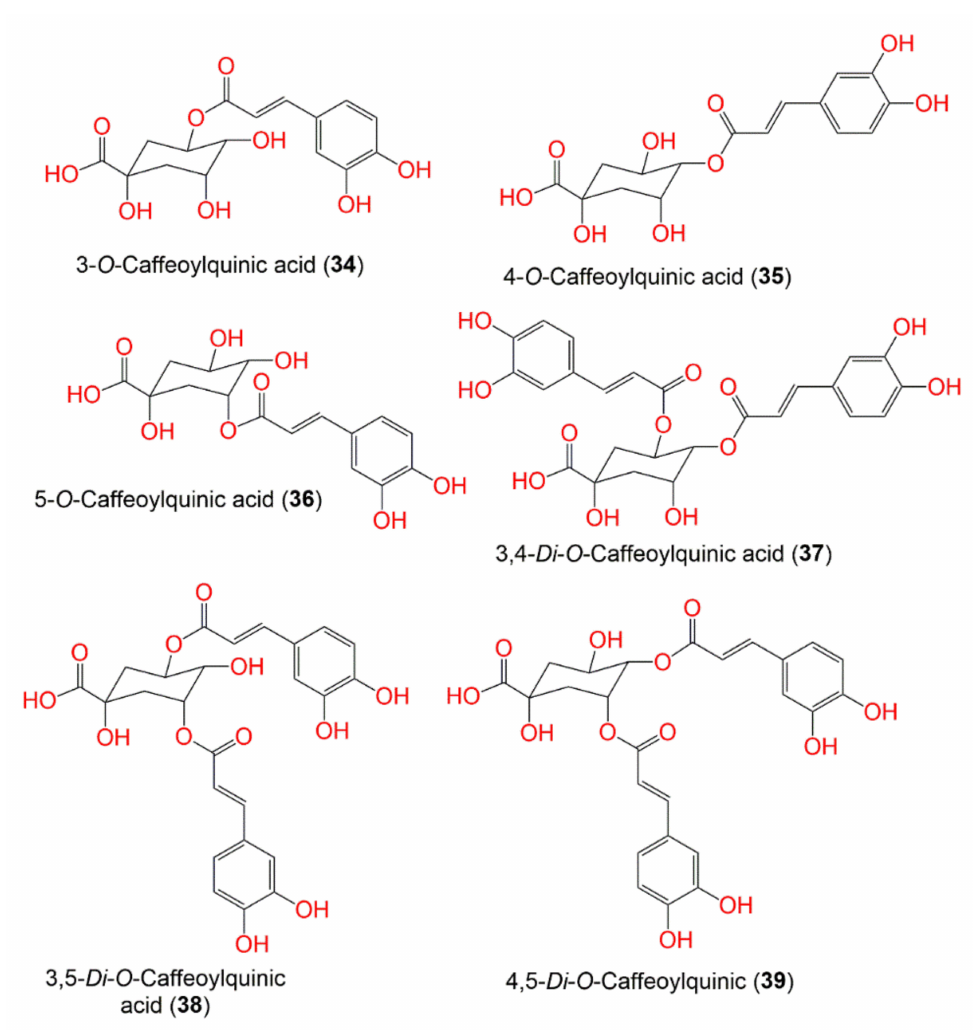
Figure 4. Structures of compounds 34 – 39